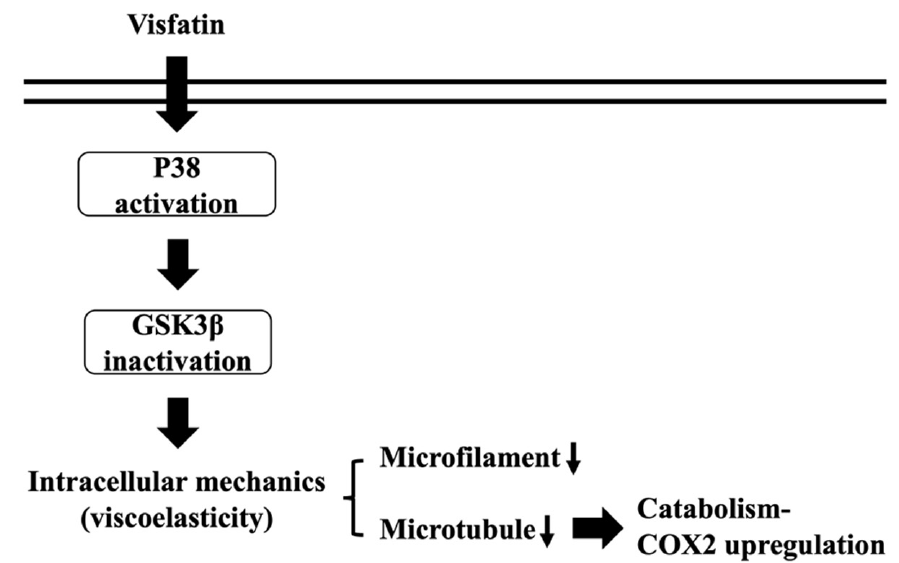
Figure 8. Schematic representation of the signaling regulating visfatin-induced effects on intracellular mechanics and catabolism in human chondrocytes.